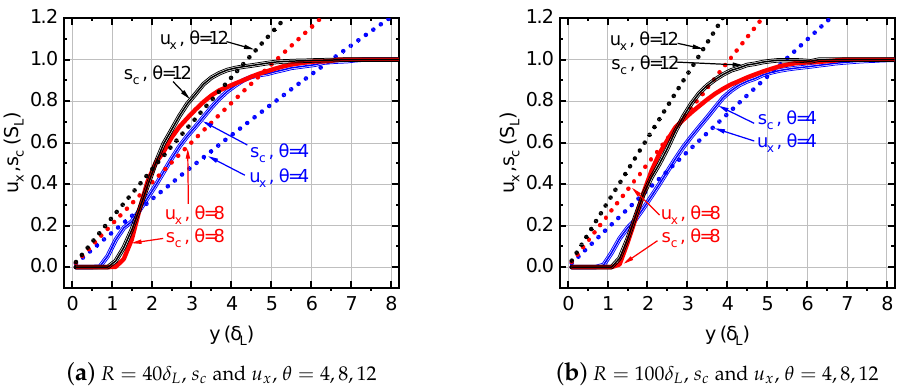
Figure 12. Comparison of the consumption speed s c ( y ) and the incoming flow velocity u x ( y ) under the critical condition for the channel half-widths R = 40,100 δ L and θ = 4,8,12 (isothermal